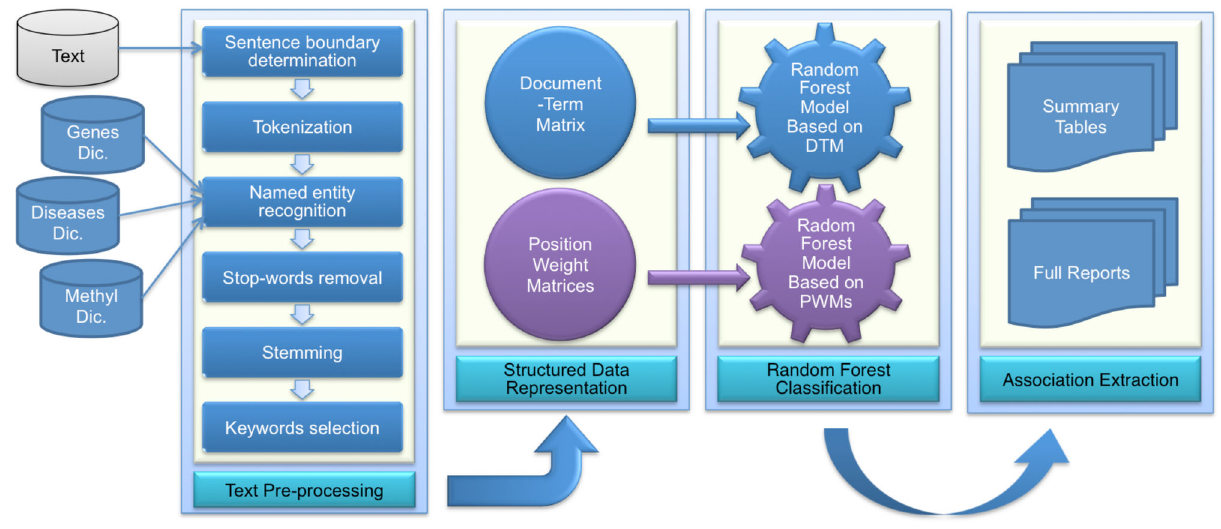
Figure 1. DEMGD system architecture. The input to the system is the Input Text, and the output is Summary Tables and Full Reports. The system consists of four modules: Text Pre-processing, Structured Data Representation, Classification and Associations Extraction. doi: